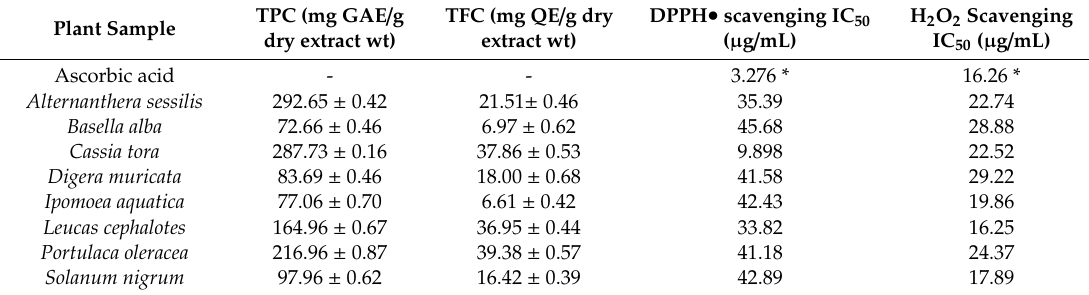
Table 2. Total phenolic and flavonoid contents of selected wild leafy plants ( n = 3). TPC (mg GAE / Plant Sample